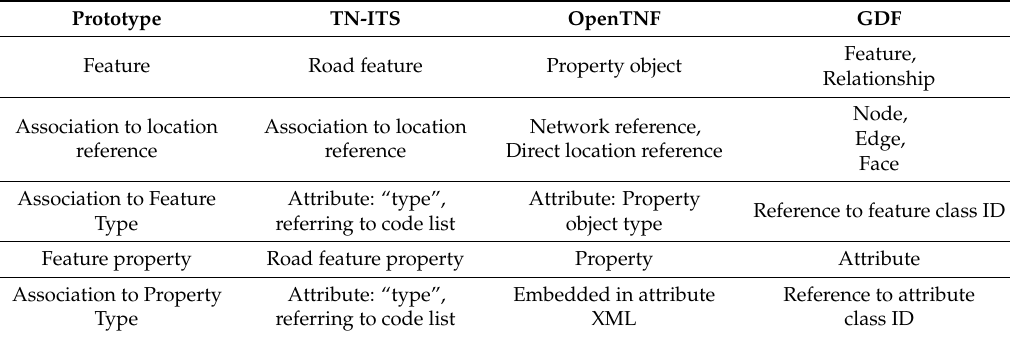
Table 7. Comparison of concepts from generic feature